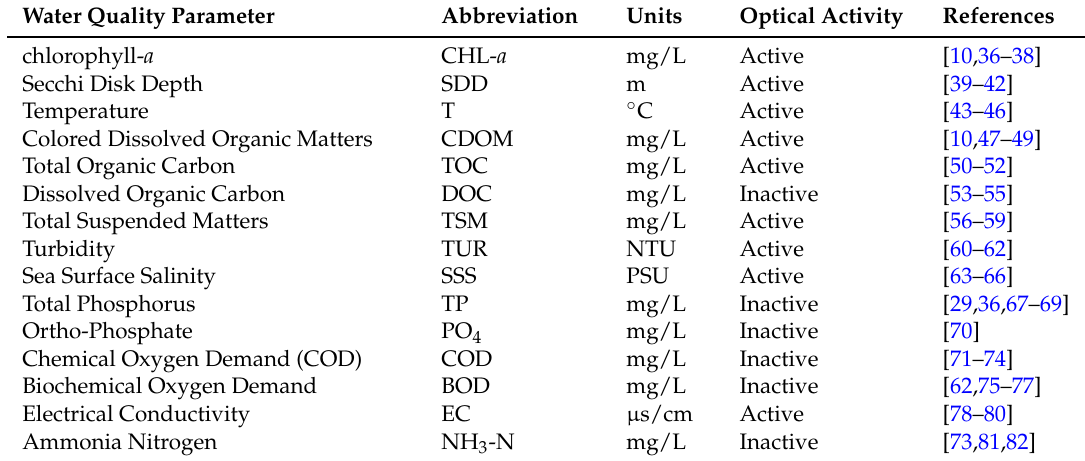
Table 4. The most commonly measured qualitative parameters of water by means of remote sensing. Water Quality